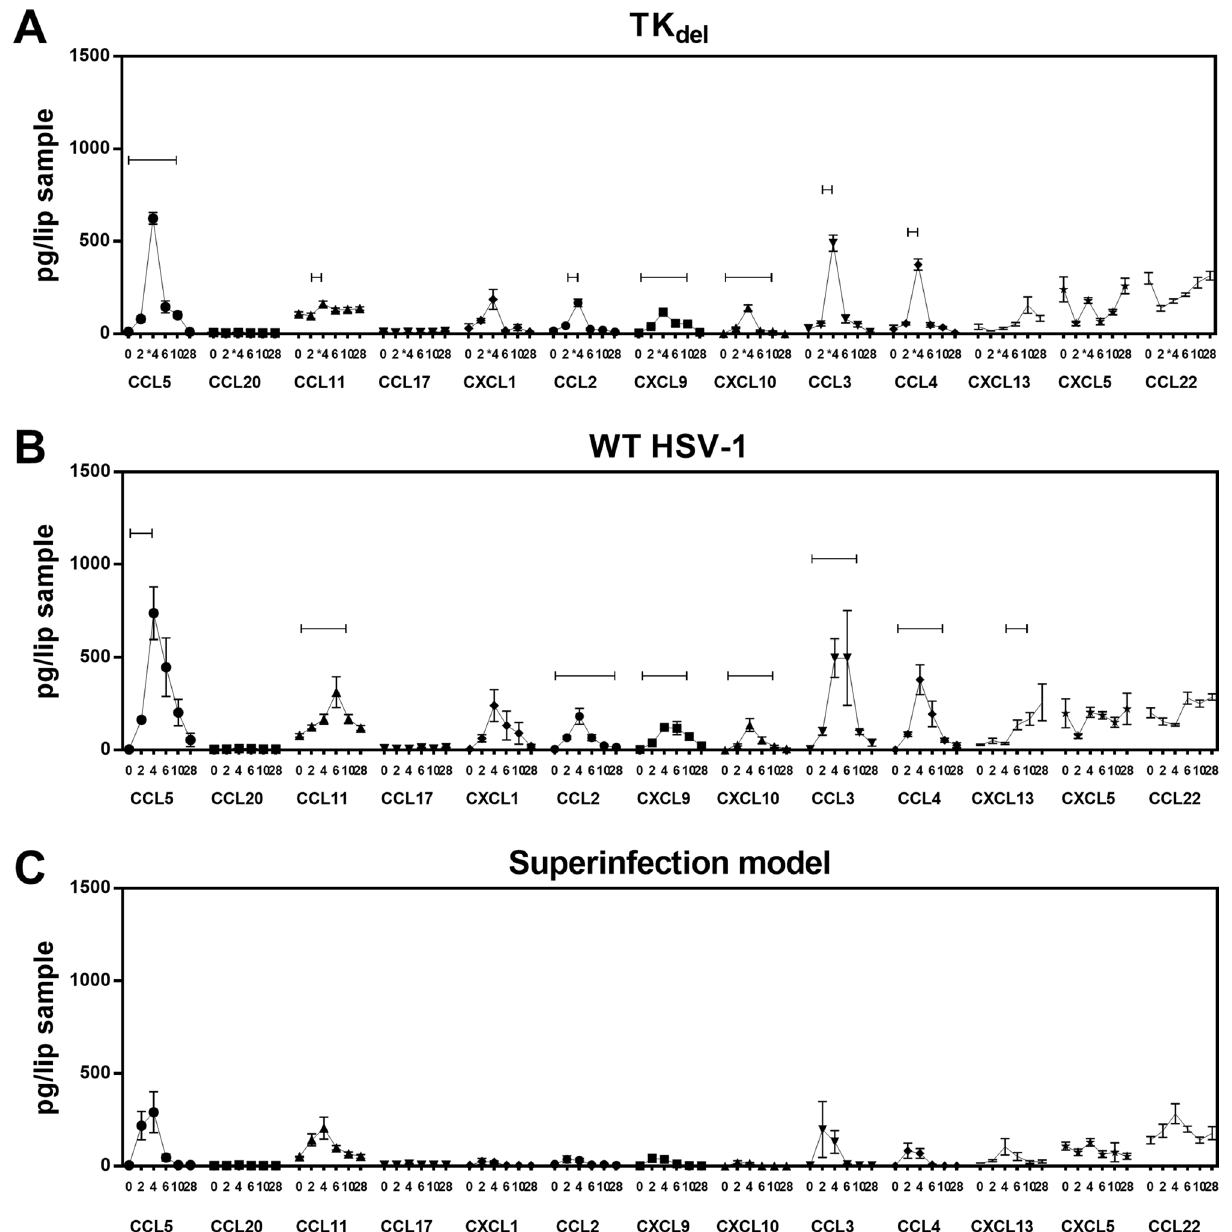
Figure 6. Inflammatory chemokines at the lip site of inoculation. Naïve mice were infected in the lip with TK del ( A ), or WT HSV-1 ( B ) on day 0. Mice of the superinfection model were initially inoculated with TK del in the right lip on day -4 and then superinfected with WT HSV-1 on day 0 in the left lip ( C ). Mice were randomly culled at indicated time points and inflammatory chemokines in non-denatured lip tissue lysates were quantified using multi-analyte flow cytometry assay. Bars indicate significant difference from uninfected day 0 ( p < 0.03; T-test ). Each point represents n = 4 independent biological replicates. Figures were formulated using LEGENDplex software, Excel and